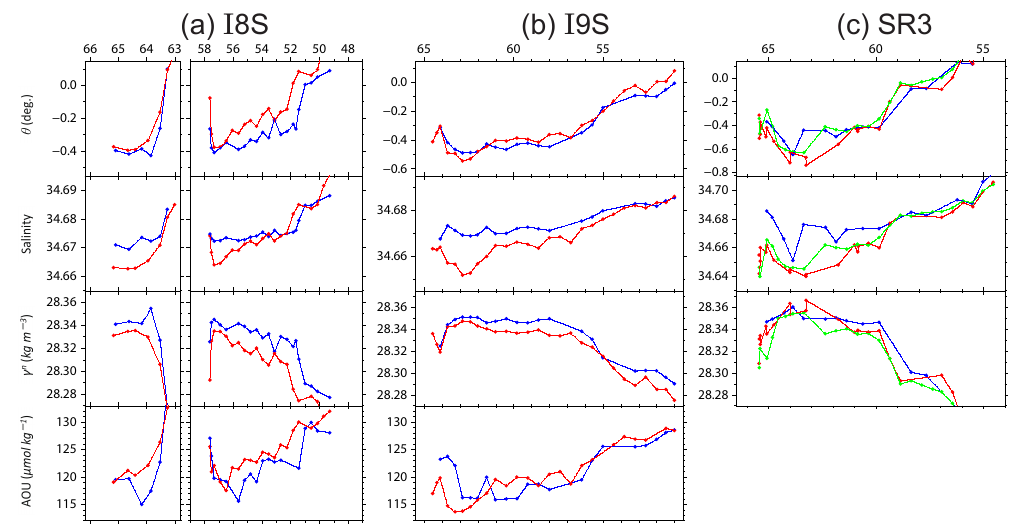
Fig. 2. Meridional variations of the water properties averaged over the 100m-thick layer at the bottom for (a) I8S, (b) I9S and (c) SR3. Blue circles and lines are from the WHP occupations in the 1990s. Red circles and lines in (c) are from repeat occupations in the year 2001